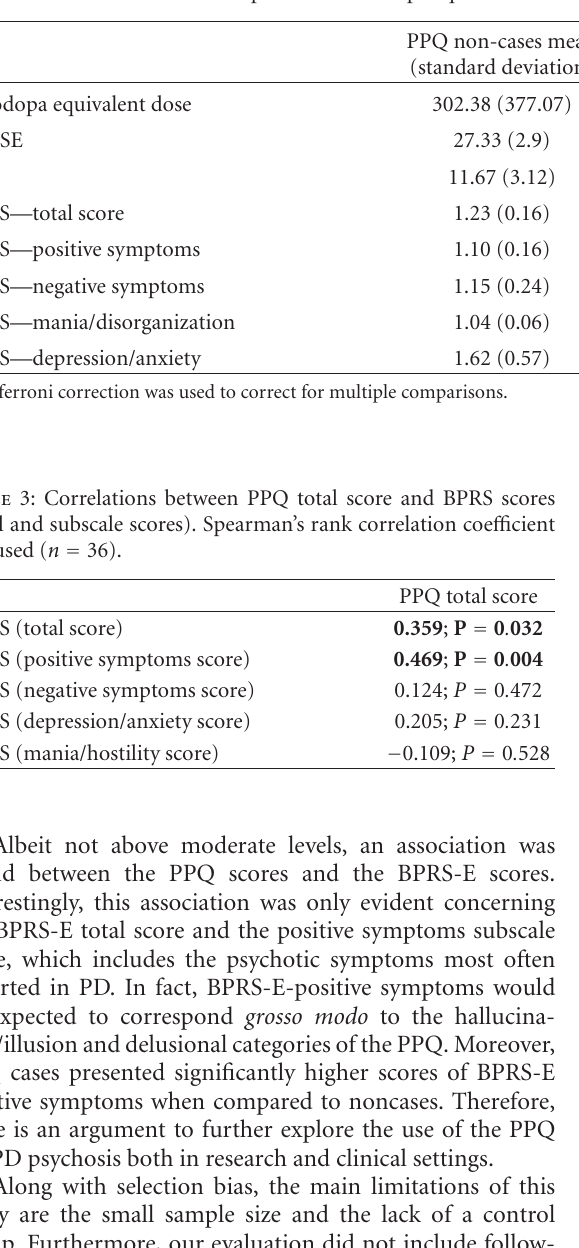
Table 2: Comparison of levodopa equivalent dose and BPRS scores between PPQ cases and noncases.